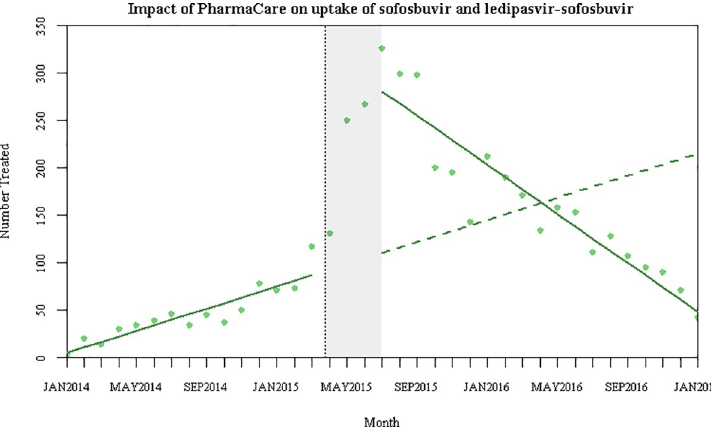
Fig 1. Interrupted time series model for the impact of PharmaCare on treatment uptake of sofosbuvir and ledipasvir-sofosbuvir. The last data point (January 2017) only covered a partial month as the last treatment